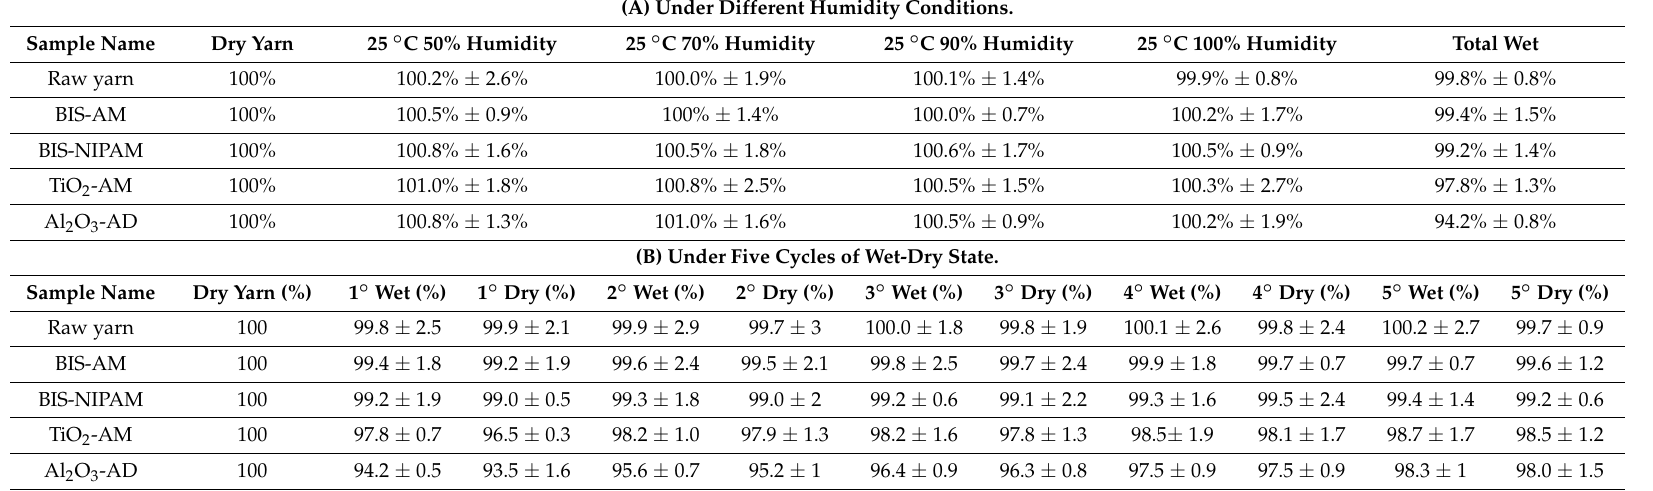
Table 2. Length variation of hydrogel-coated wool yarns, after pre-treatment with urea (8 M) followed by hydrogel coating on the surface of wool yarns using UV irradiation to trigger the polymerization. Hydrogel precursor formulations: BIS-AM (0.4% BIS + 1 M AM); BIS-NIPAM (0.4% BIS + 1M NIPAM); Nano-TiO 2 -AM